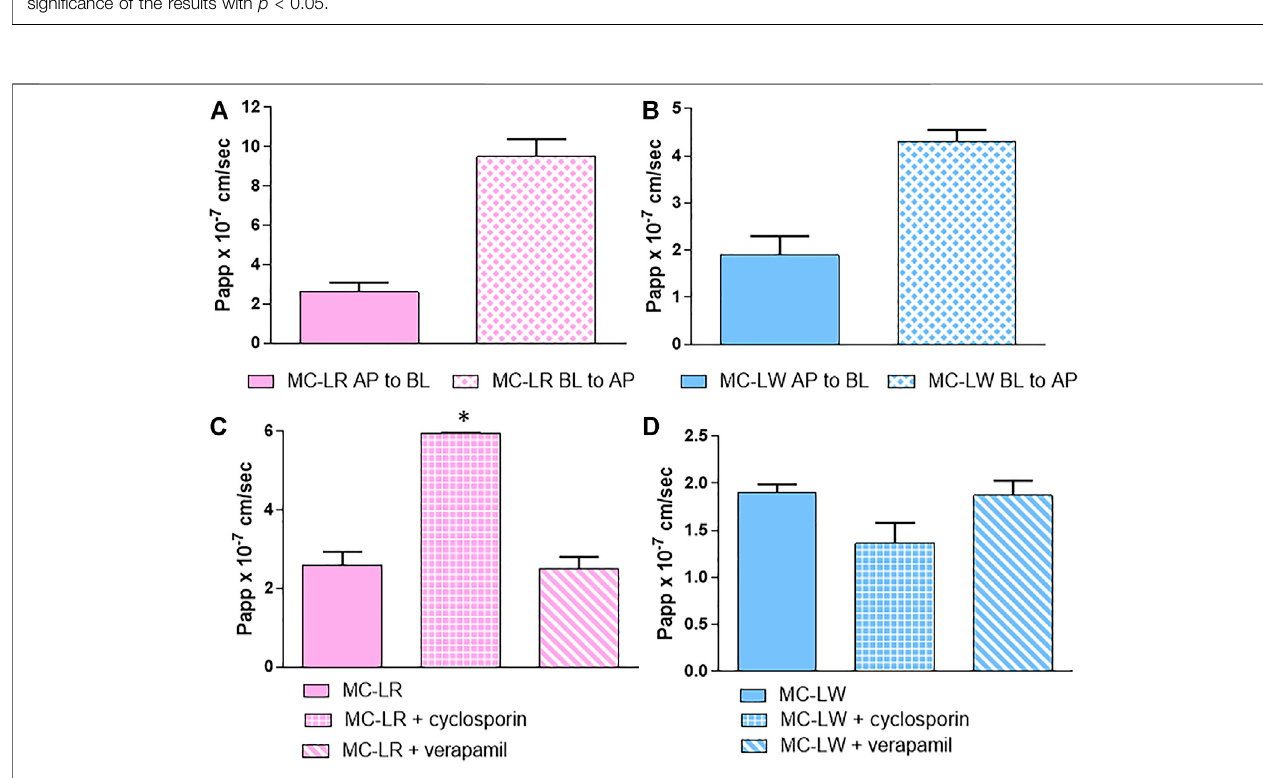
FIGURE 5| Bidirectional absorption kinetic: Papp values (AP-BL) and (BL-AP) of (A) MC-LR and (B) MC-LW. Papp values of MC-LR (C) and MC-LW (D) with and without cyclosporin and verapamil: from left to right MC without inhibitor, MC with cyclosporin and MC with verapamil. Toxin concentration was 40 μ M; study duration was4 h.Atleasttwoindependentexperimentsondifferenttissuelotsfromthesamedonorhavebeencarriedout,eachinduplicates.Resultsareexpressedasmeans± standard deviations. Stars represent statistical signi fi cance of the results with p < 0.05.